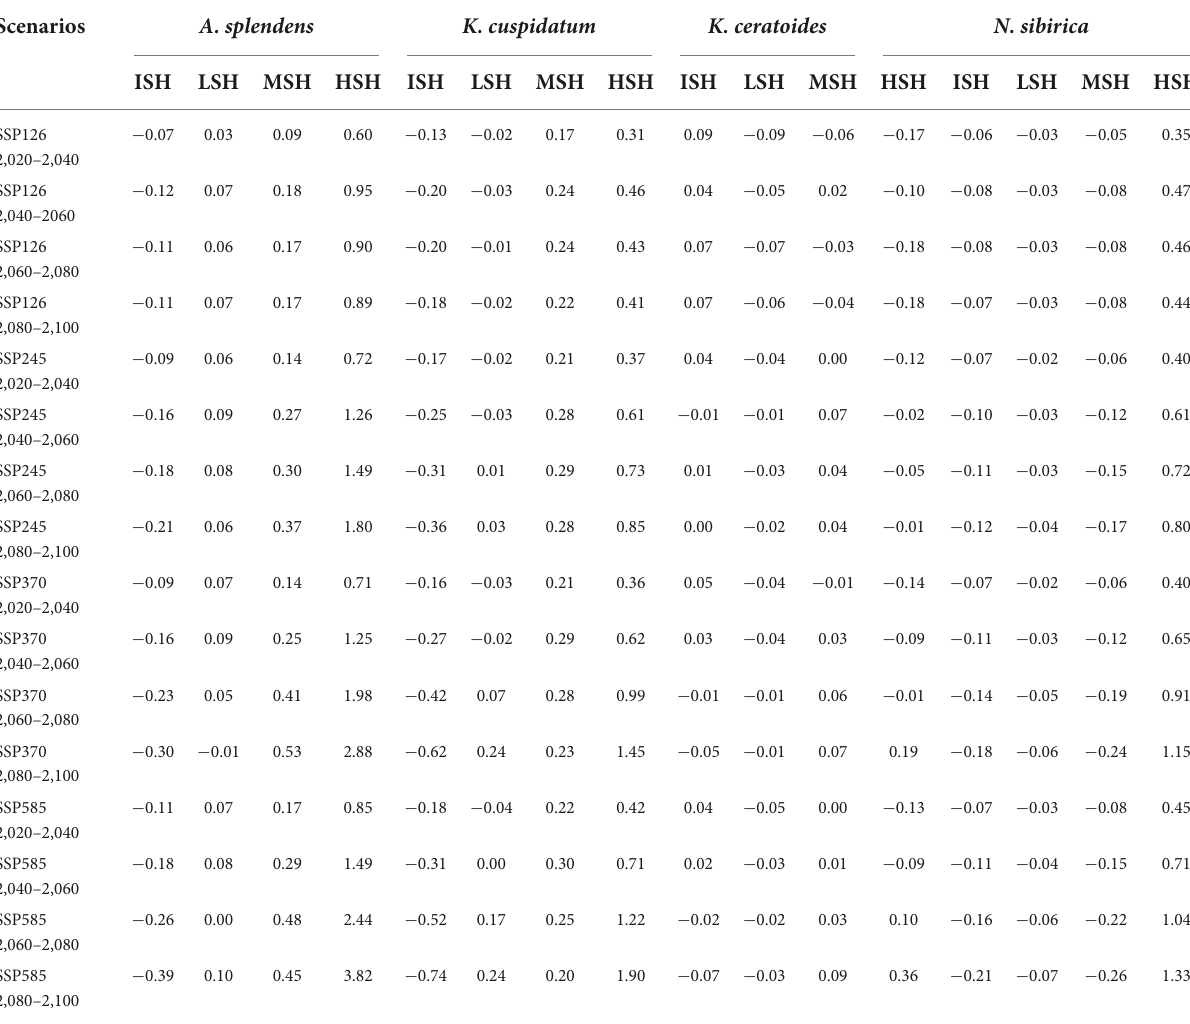
TABLE 3 The change trends of the host plants under different